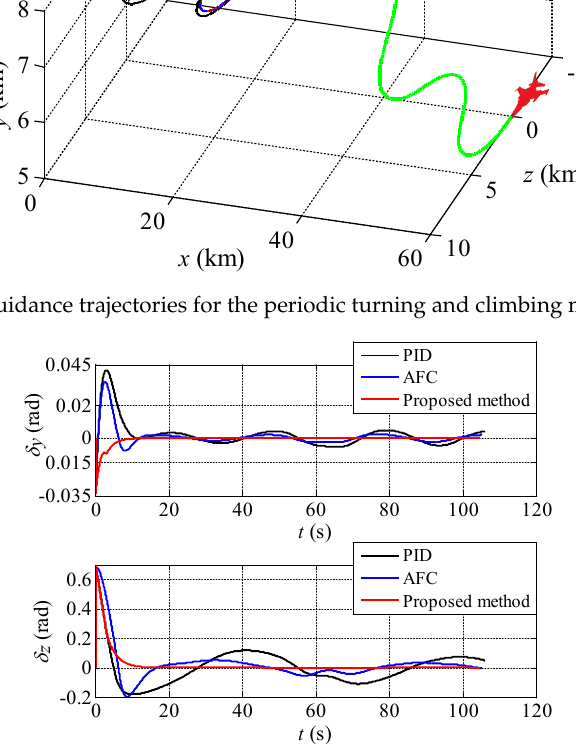
Figure 12. The aiming error angles of the UCAV during the process of attack